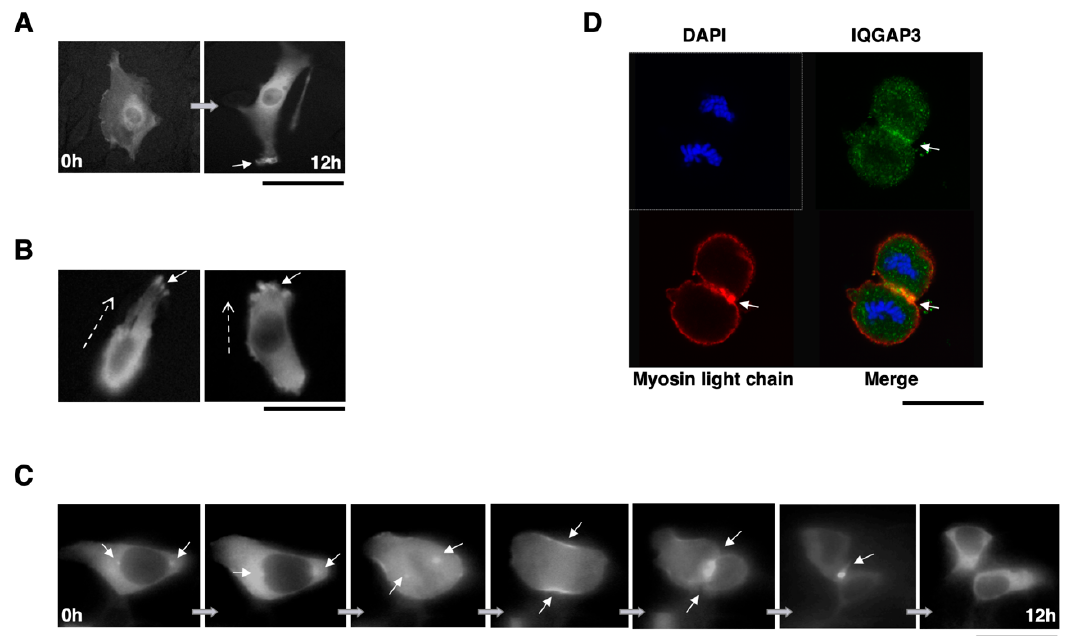
Figure 7. IQGAP3 is involved in cytokinesis. ( A ) Accumulation of IQGAP3 at the cell cortex area that subsequently underwent filopodia and lamellipodia formation in NIH3T3-IQGAP3 cells (arrow). ( B ) Accumulation of IQGAP3 at the leading edge of migrating cells (arrows). Dashed arrows; the direction of migration. ( C ) Representative images of subcellular localization of IQGAP3 during mitosis and cytokinesis in NIH3T3 cells expressing IQGAP3-GFP. IQGAP3 is localized at the spindle poles, contractile ring and cleavage furrow during cell division (arrows). ( D ) Co-localization of endogenous IQGAP3 and myosin light chain by immunocytochemical analysis in ST-4 cells. IQGAP3 and myosin light chain showed co-localization at the contractile ring during cytokinesis (arrow). Scale bars; 50 µ m for A-D.